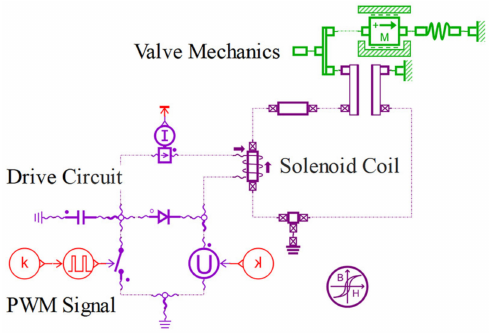
Figure 11. Electromagnetic dynamic model of the LSV.